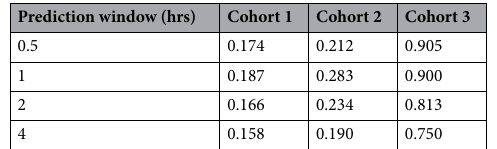
Table 3. Incidence rate of adverse outcomes in each cohort.